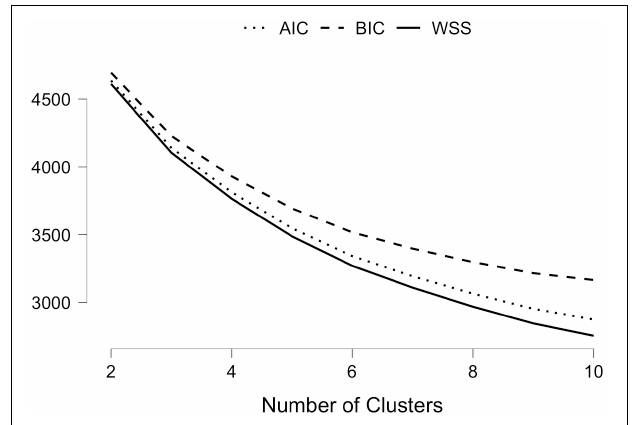
FIGURE 2 | The elbow method